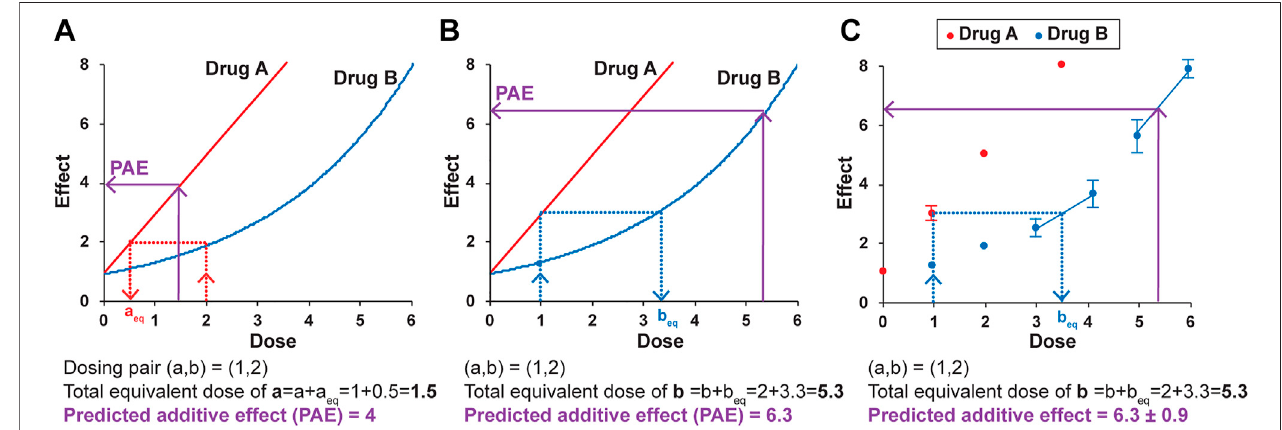
FIGURE 3 | The principles of Loewe Additivity and their application to the DE/ZI method. A predicted additive effect (PAE) is determined by calculating a total equivalent doseusing eitherthedosing curve fordrug A (A) ordrug B (B) ,and then interpolating usingthesamedosing curvetodetermine thepredicted effect.Seetext fordetails. (C) Apredictedadditiveeffectisdeterminedusingthedose-effectdataforDrugB,herewiththenearest-neighbormethod.Thetwonearestpointstotheeffect or dose of interest are used for interpolation. The error in the predicted additive effect is generated by a Monte Carlo simulation in the R code, as described in the Methods. The values given here are for illustrative